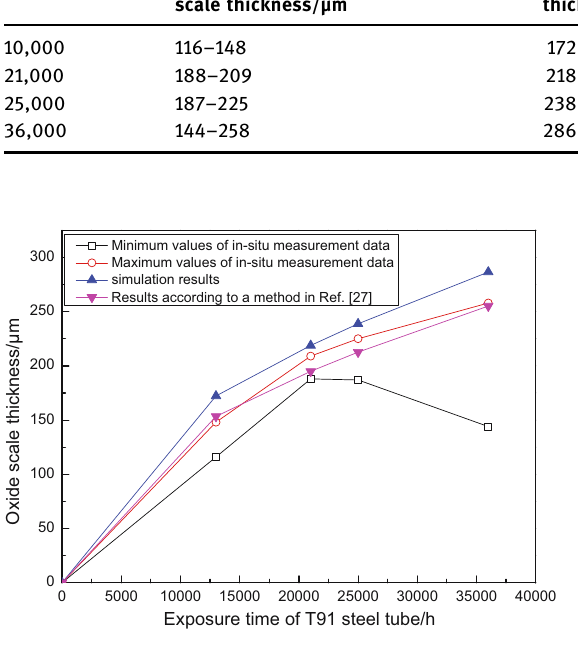
Figure 11: The oxide scale thickness of last stage superheater tubes for in situ measurement data, predicted results, and calculation results according to a method in ref. [ 27 ]